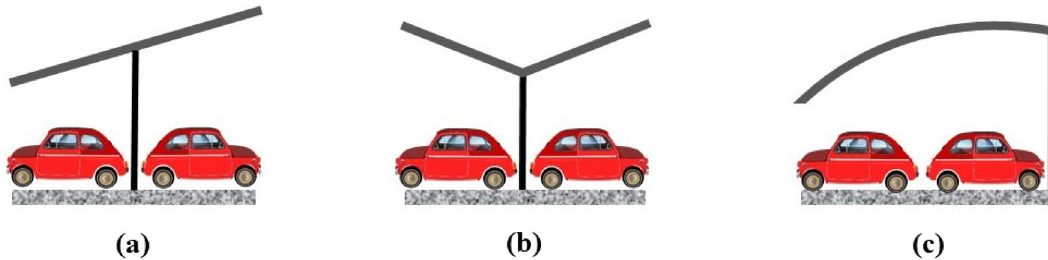
Figure 9. Design of various carport canopies as ( a ) Mono-pitch canopy, ( b ) Duo-pitch canopy, and ( c ) Barrel arch